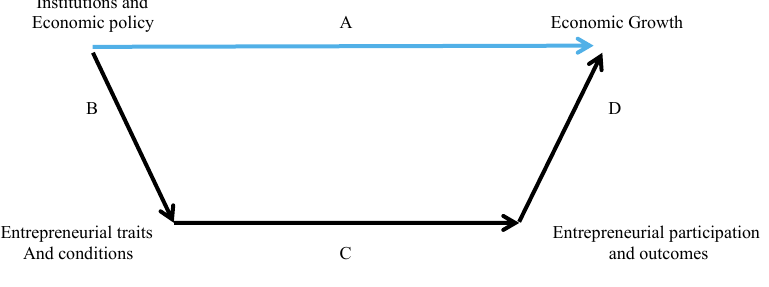
Fig. 1 – Diagram of a basic moderation model – Conceptual Diagram. Source: Coleman